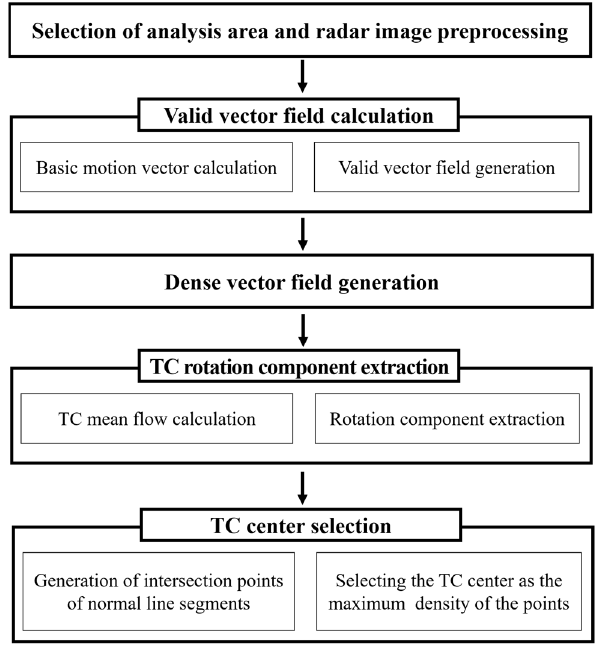
Figure 1. Flowchart of the ACTION algorithm methodology.